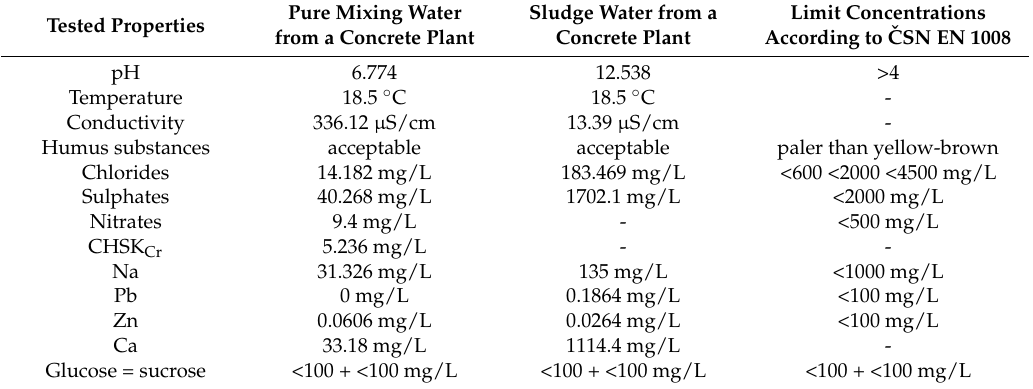
Table 1. The results of analyzes of samples of pure mixing water and sludge water from a concrete plant. Tested